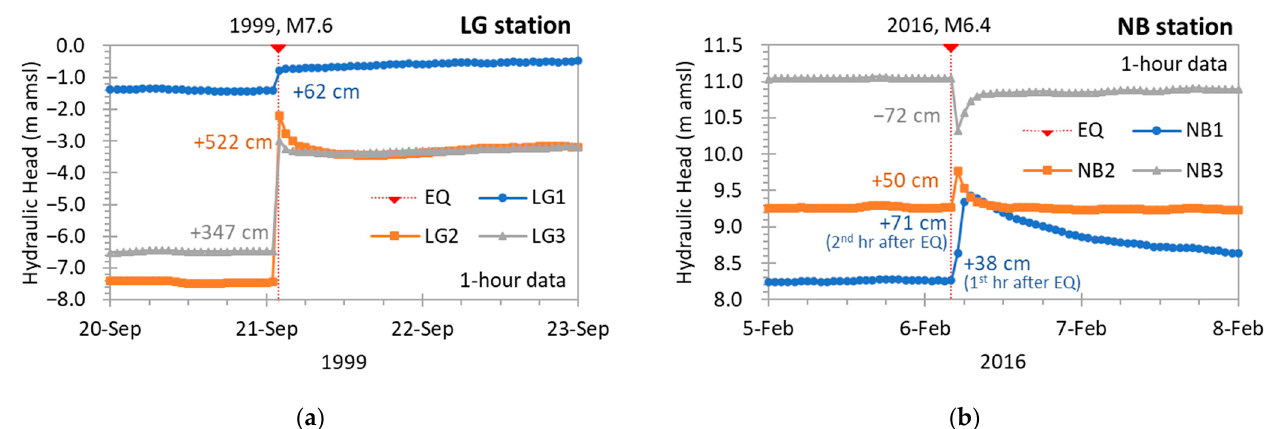
Figure 7. Vertical distribution of coseismic changes in the multiple-well stations: ( a ) the magnitude of coseismic rises changed with depths at the LG station during the 1999 M7.6 earthquake; ( b ) two coseismic rises and one fall were recorded in wells of different depths at the NB station during the 2016 M6.4 earthquake.